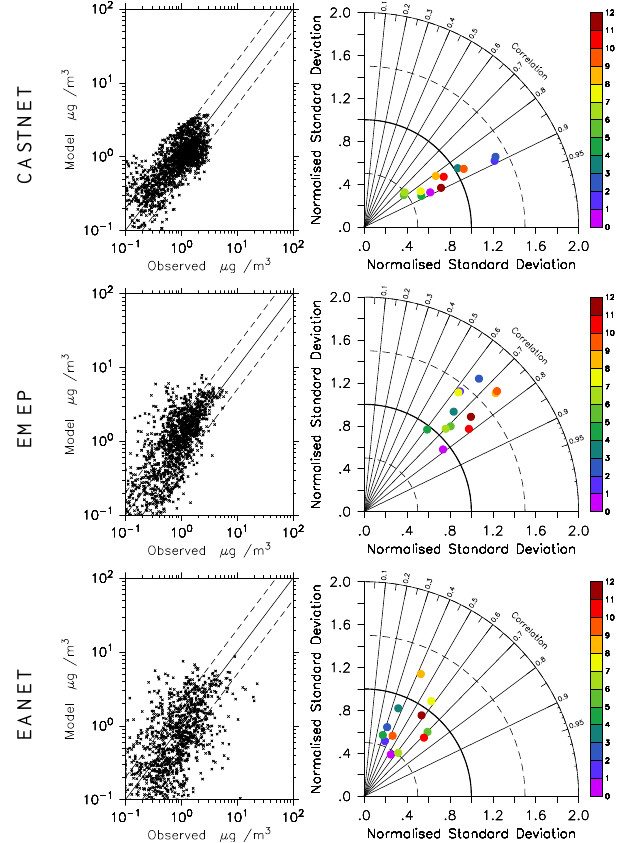
Fig. 10. As Fig. 6 but for NH +